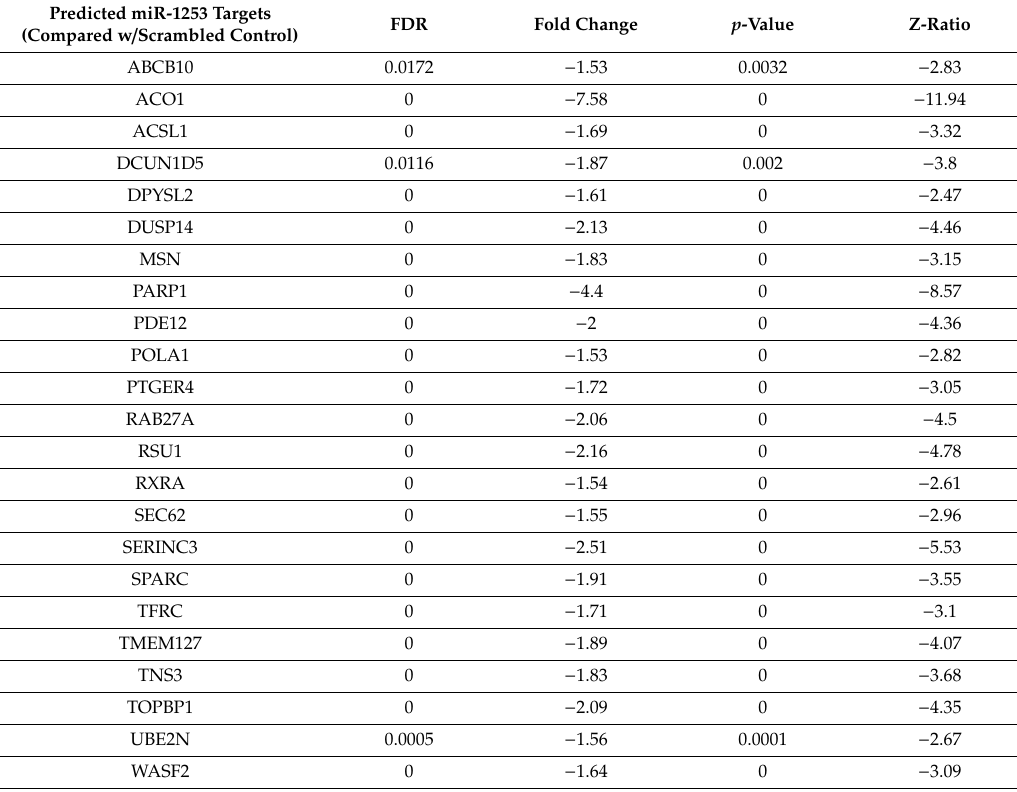
Table 1. Summary of the predicted miR-1253 targets repressed in HAECs